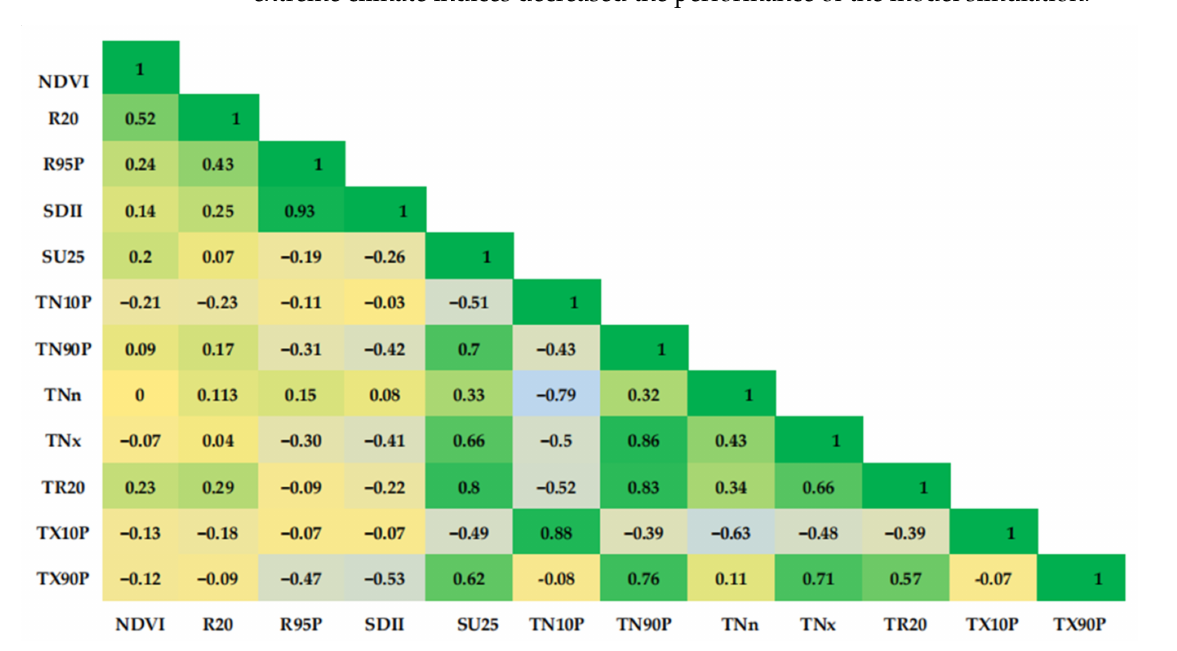
Figure 8. Correlations between extreme weather events and the normalized difference vegetation index (NDVI) on the Mongolian Plateau. (From green to blue, the correlation goes from positive to negative).